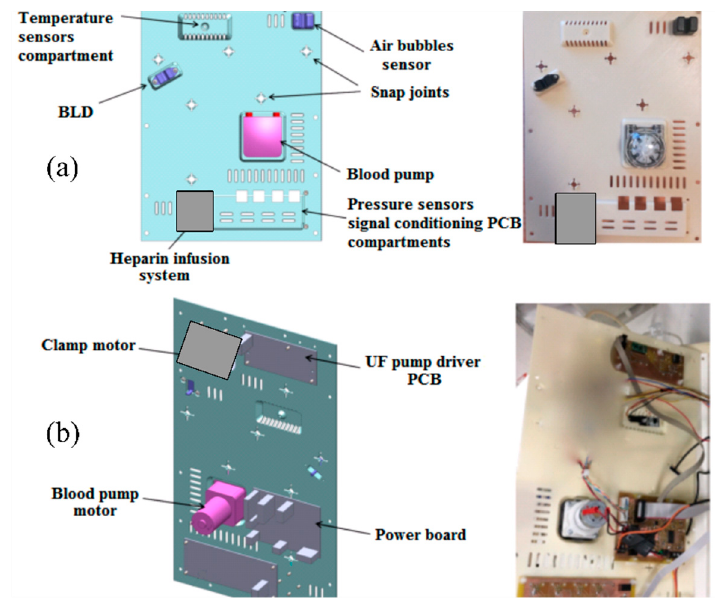
Figure 3. Front and back views of intermediate panel with the non-disposable components of the RAP: 3D sketch and manufactured prototype, ( a ) front side, ( b ) back side.